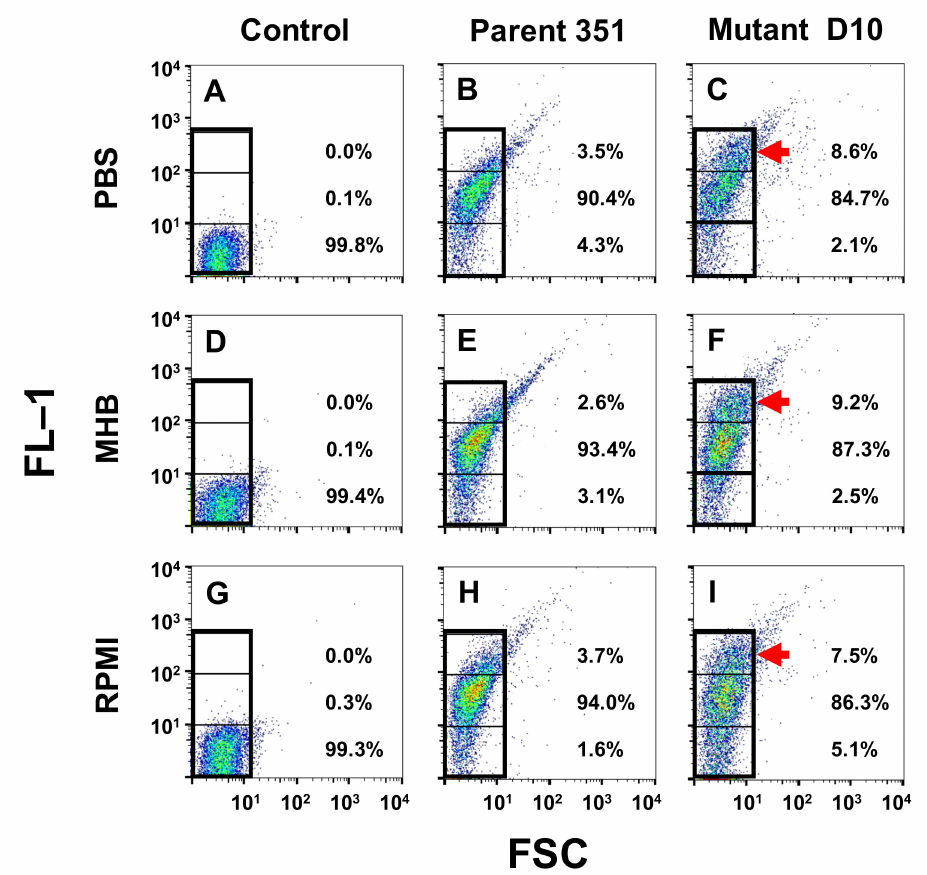
Figure 1. Comparative binding of BODIPY-DAP to DAP-S and 351-D10 DAP-R study strains under distinct conditions in vitro ( A–I ). Exposure of strains to BODIPY-DAP under different conditions (PBS, MHB or RPMI) was performed as detailed in the Methods Section. Percentages of the total cell population meeting FL-1 gating criteria (black boxes) are indicated, corresponding to low-binding (0–10 1 ), high-binding (10 1 –10 2 ) and hyper-accumulating (>10 2 ). Note the substantial 2- to 4-fold increase in hyper-accumulating subpopulations in DAP-R strain D10 ( C , F , I ; red arrows) vs. the same gating in DAP-S strain 351. Mean channel fluorescence of strain D10 hyper-accumulating subpopulations was 219 ± 48 (PBS), 224 ± 53 (MHB) and 212 ± 39 (RPMI) fluorescence units, as compared to 62 ± 22 (PBS), 53 ± 16 (MHB) and 69 ± 31 for high-binding or 7 ± 2 (PBS), 8 ± 3 (MHB) or 9 ± 3 (RPMI) for low-binding populations, respectively. FSC, forward